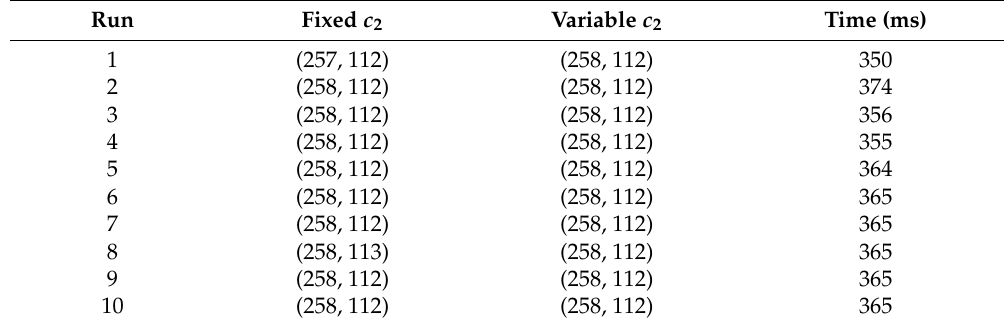
Table 4. PSO results for experiment 1 obtained with both fixed value variable values for the c 2 parameter. The ground truth is (258,